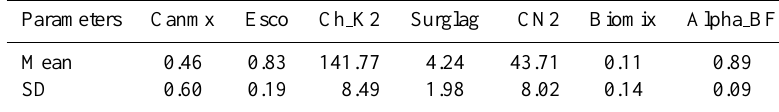
Table 2. Mean and stand deviation (SD) of the posterior distribution resulting from application of the ParaSol technique. Parameters